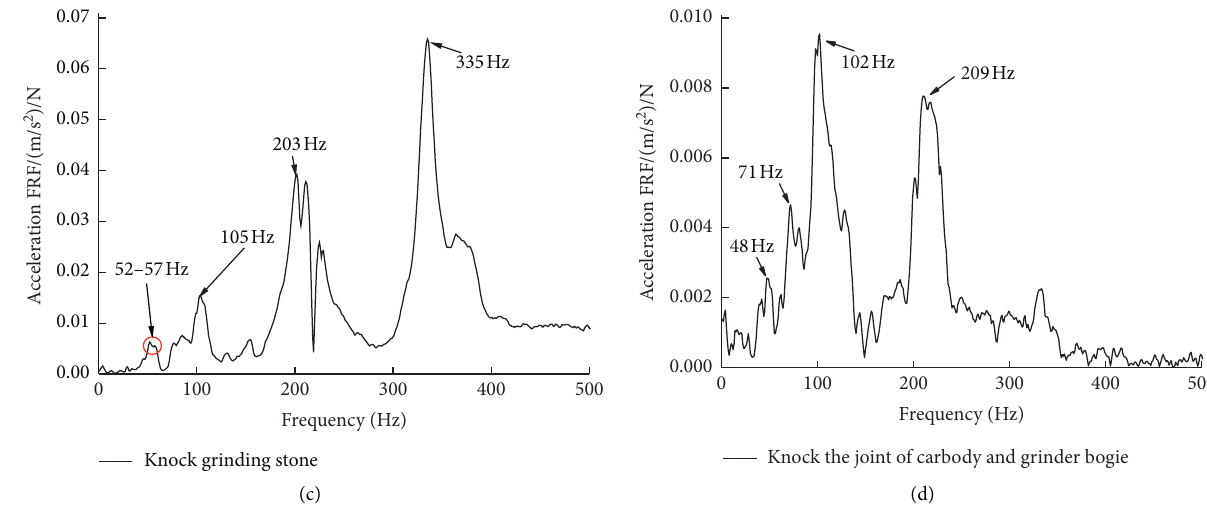
Figure 17: Acceleration frequency response of different components of the rail grinder. (a)Exciting the grinder bogie. (b) Exciting the wheel. (c) Exciting the grinding stone. (d) Exciting the joint of the car body and grinder